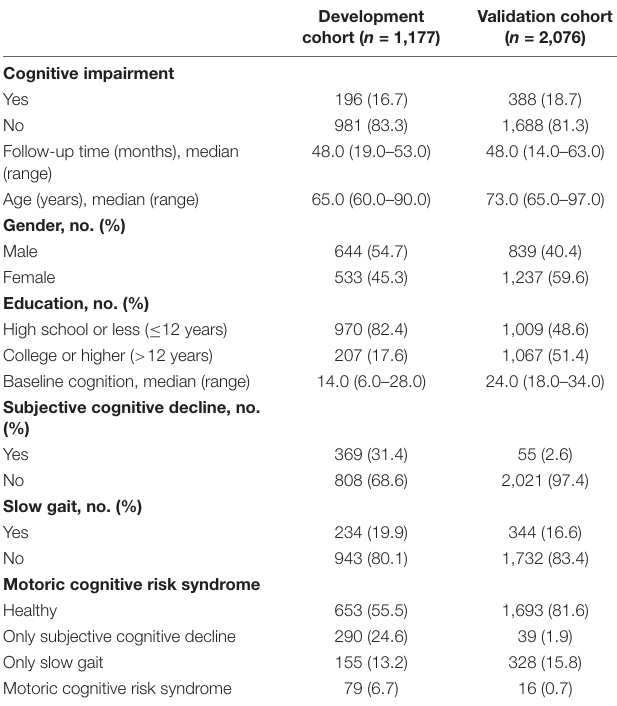
TABLE 1 | Characteristics of participants in the development and validation